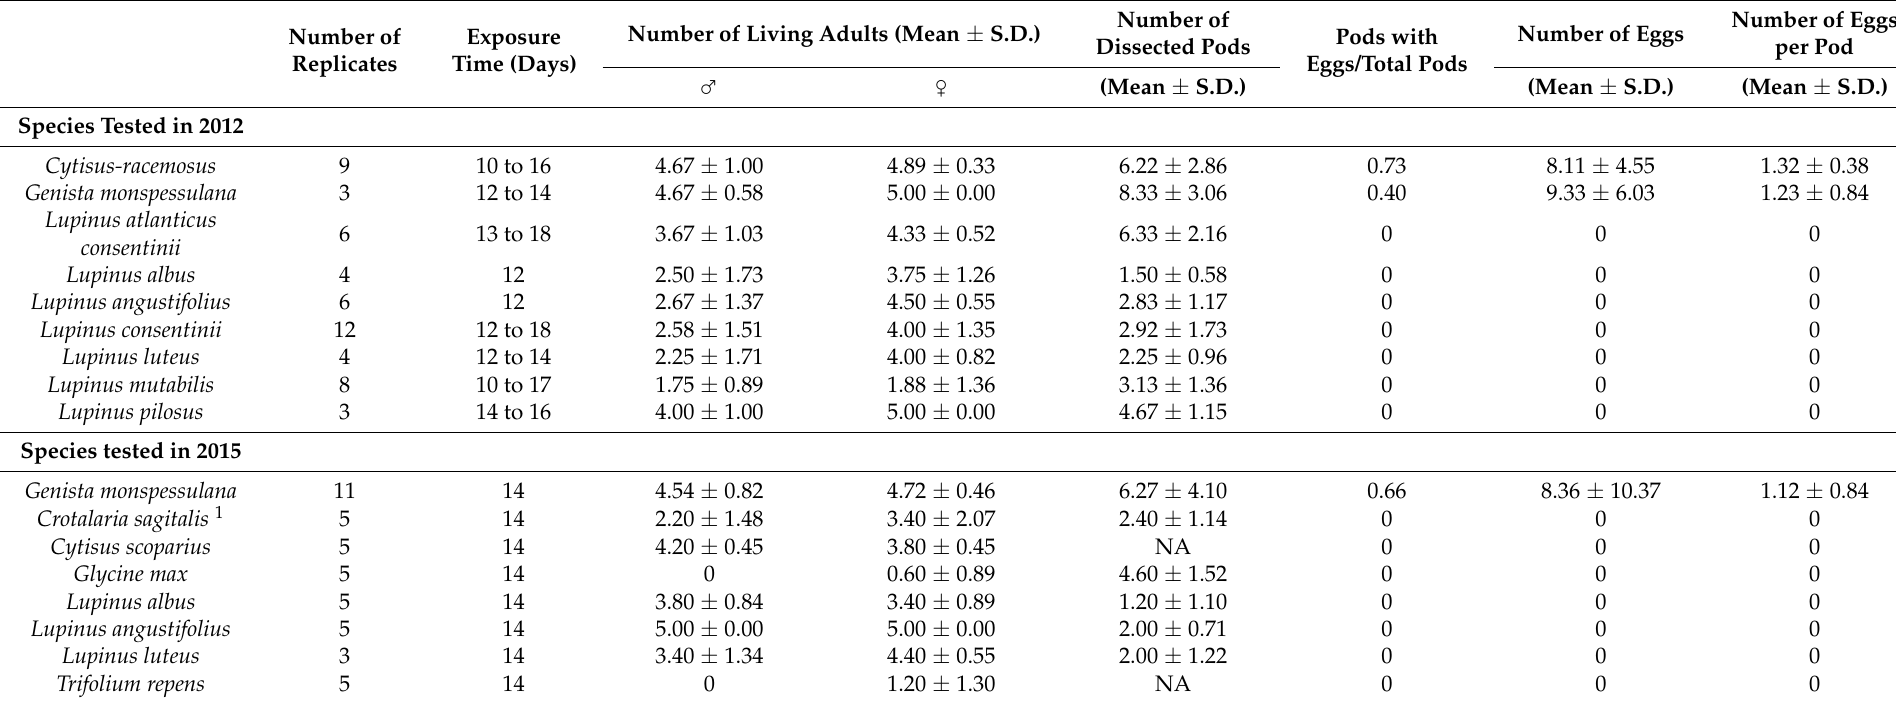
Table 2. No-choice tests on pods of test plants with Lepidapion argentatum including adult survival during exposure, and oviposition in pods in 2012 and